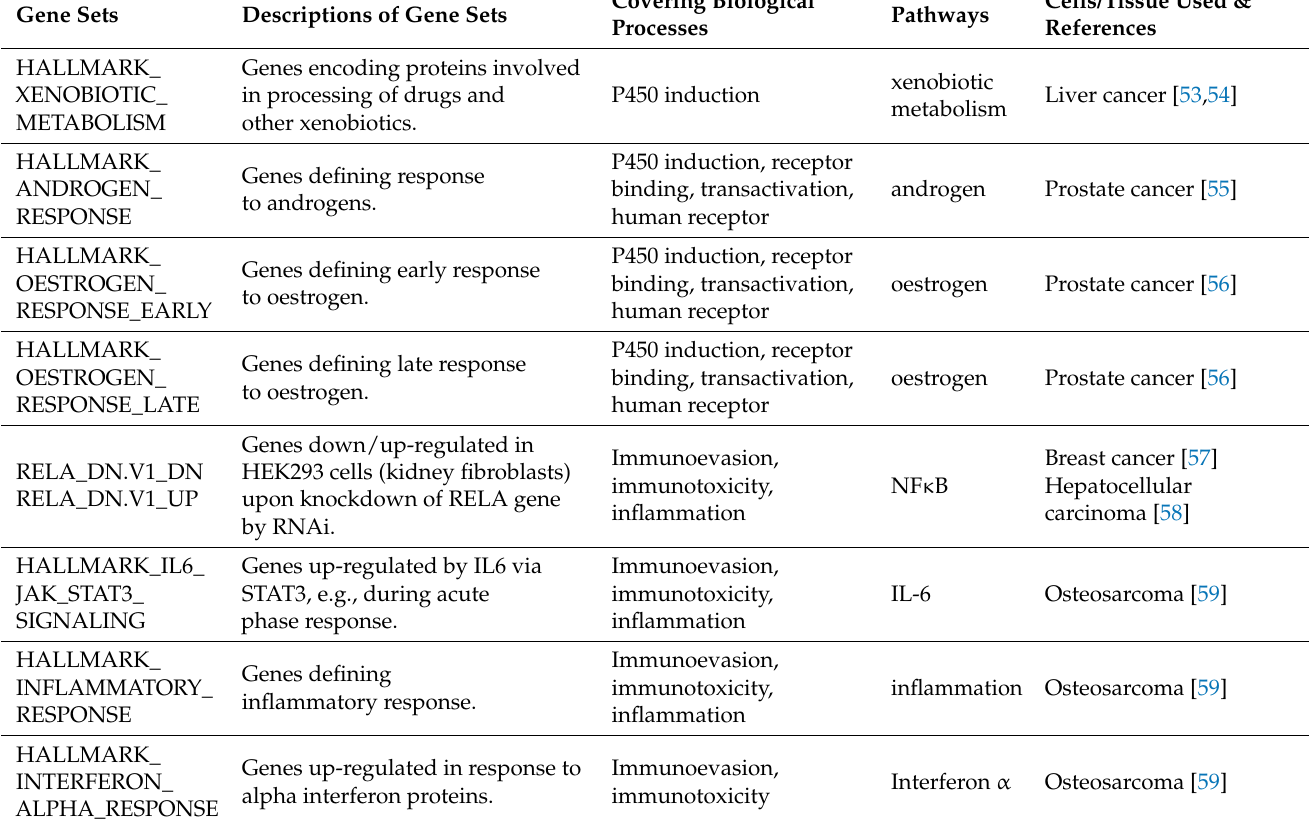
Table 2. Possible gene sets for GSEA applied to transcriptomics assays in the IATA on NGTxCs. Gene